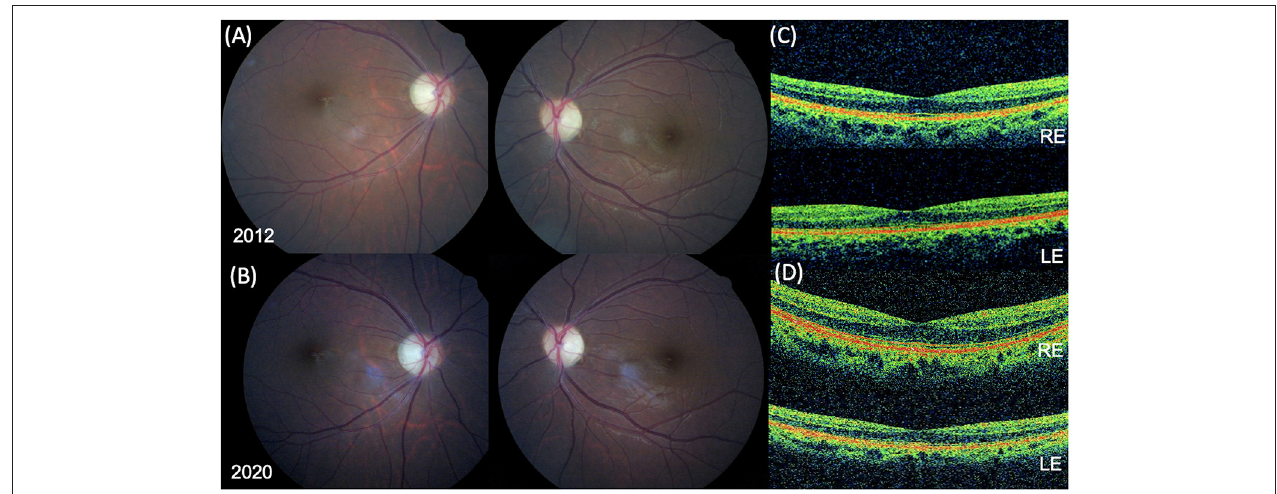
FIGURE 1 | Fundus photographs and spectral-domain optical coherence tomography (SD-OCT) findings. Fundus photograph in 2012 (A) and in 2020 (B) showing bilateral optic disc temporal pallor with normal macula in both eyes. (C) SD-OCT foveal B-scan in 2012 revealing a normal ellipsoid zone (EZ) and a central foveal thickness (CFT) of 246 µ m in the right eye (RE) and 239 in left eye (LE). (D) SD-OCT foveal B-scan in 2020 confirming a normal EZ and a CFT of 229 µ m in the RE and 239 in the LE.